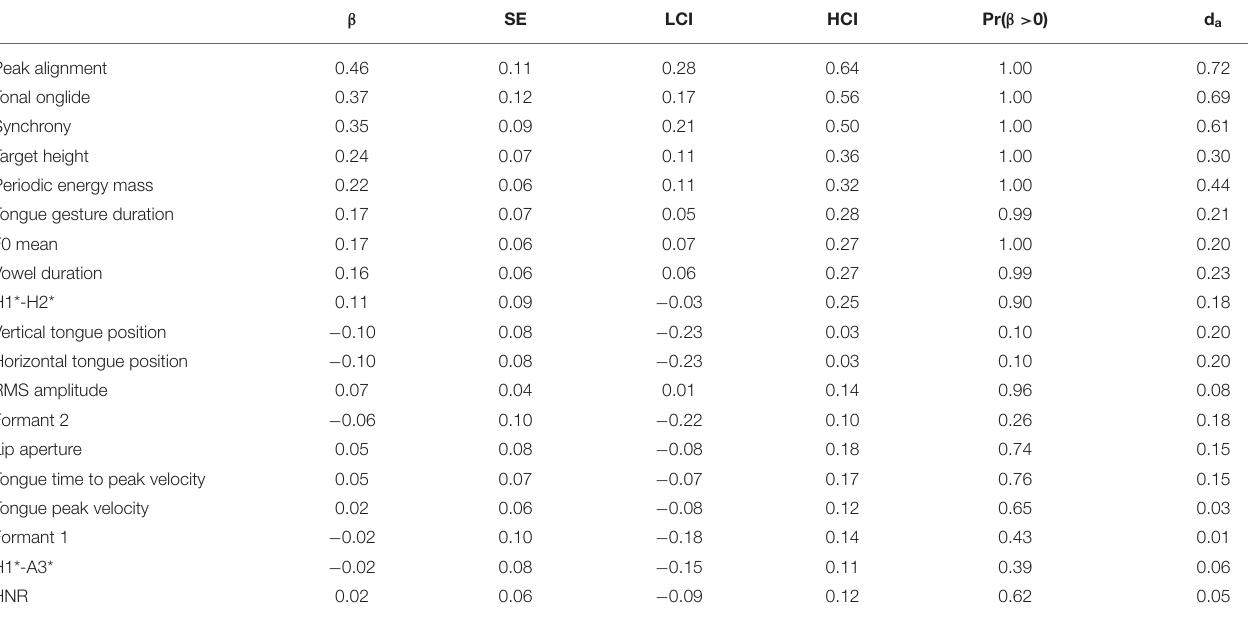
TABLE 8 | Tabular overview of modeling results for broad vs. narrow focus, vowel /o/. LCI and HCI refer to the low and high boundaries of the 90% Credible Interval.